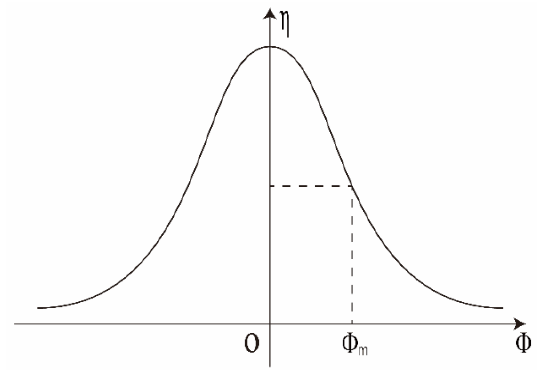
Figure 9. The complete ray transfer efficiency curve of the receiving unit.